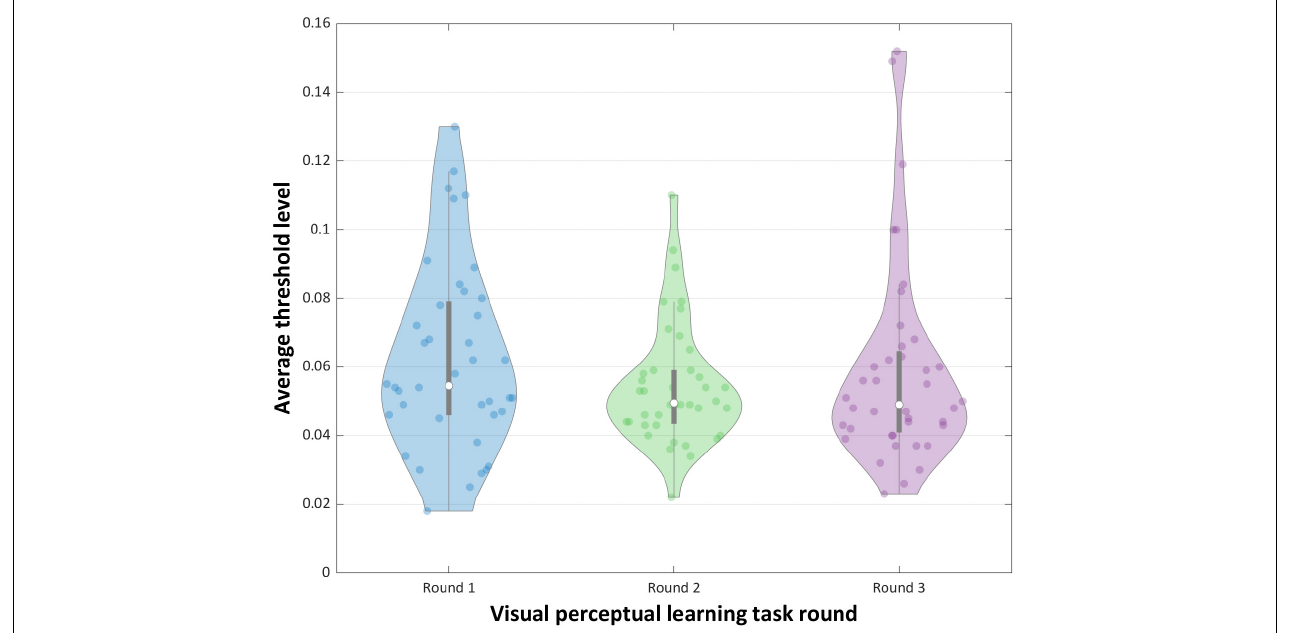
FIGURE 4 | Mean performance (threshold levels) for the VPL learning task.